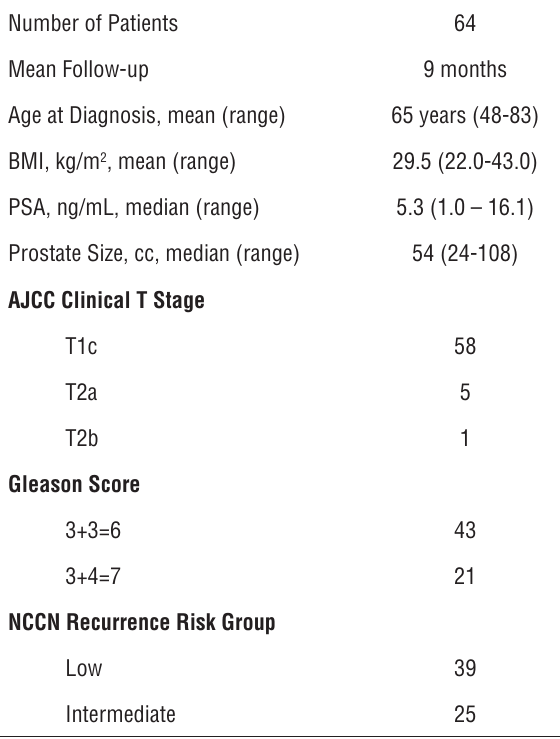
Table 1 - Patient